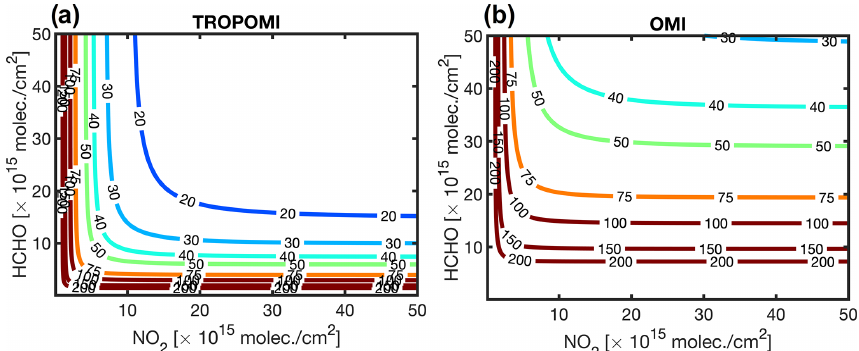
Figure 12. The contour plots of the relative errors in TROPOMI (a) and OMI (b) based on dispersions derived from Figs. 10 and 11. The errors used for these estimates are based on daily observations.